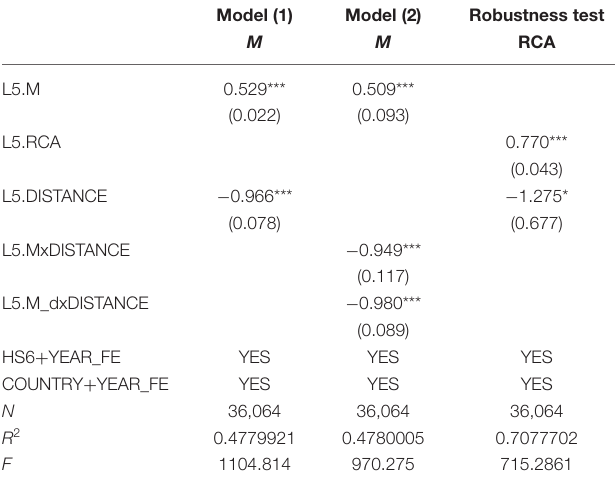
TABLE 2 | OLS model